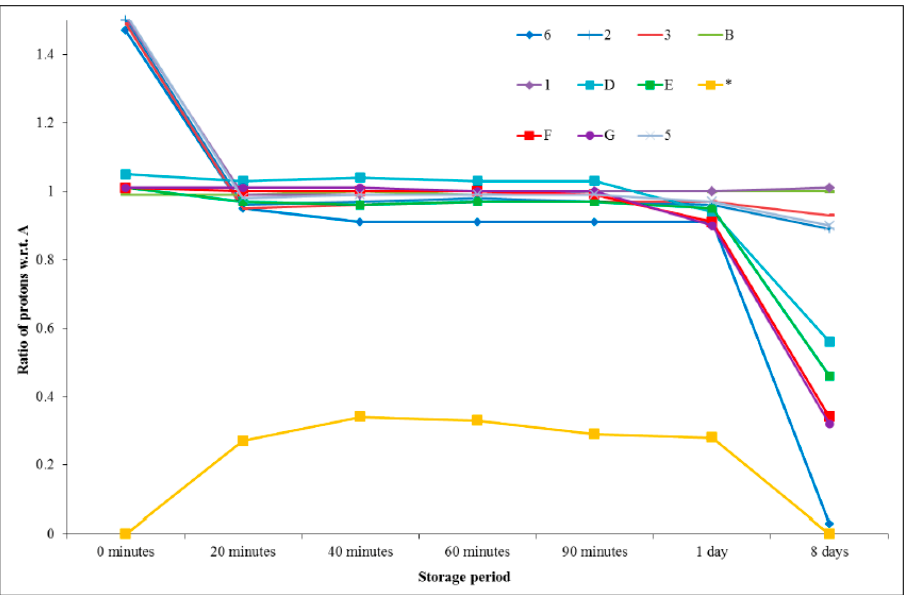
Figure 9. Changes in the ratio of proton integrals during room temperature storage for a 1:1 formulation comprising PGE and 1-ethyl-3-methylimidazolium thiocyanate.